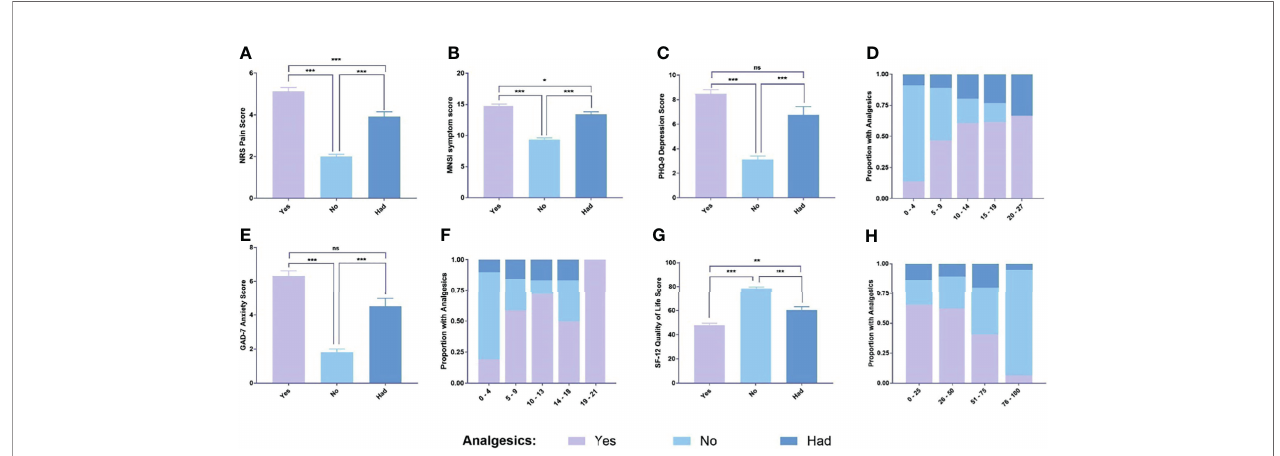
FIGURE 1 | Different scale scores. (A) NRS scores for each group; (B) MNSI symptom score of each group; (C) PHQ-9 scores for each group; (D) Distribution of PHQ-9 scores in each group; (E) GAD-7 scores for each group; (F) Distribution of GAD-7 scores in each group; (G) SF-12 scores for each group; (H) Distribution of SF-12 scores in eachv group. Data are means ± SEM. ns, no signi fi cance. *P < 0.05, **P < 0.01 and ***P < 0.001.